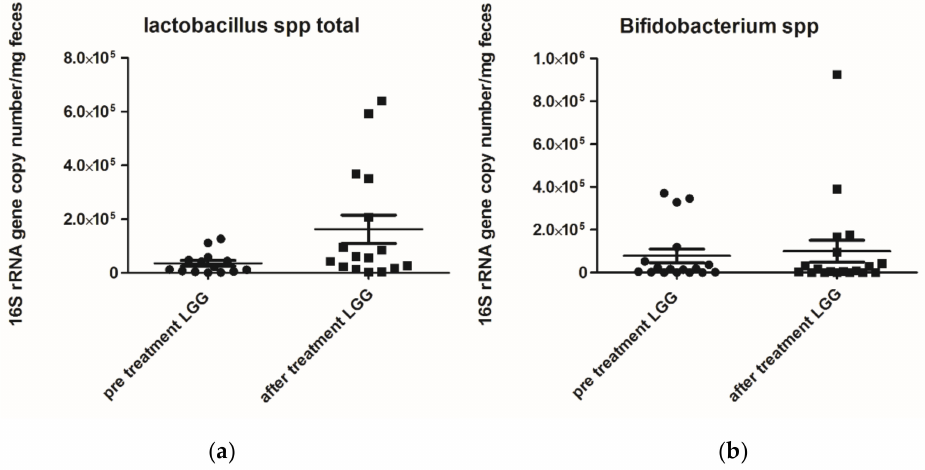
Figure 2. ( a ) Lactobacilluss spp. 16S rRNA gene copy number (mg / faeces) pre- and post-treatment with Lactobacillus rhamnosus ATCC 53103 (LGG) p value 0.0483; ( b ) Bifidumbacterium spp. (mg / faeces) pre- and post-treatment with Lactobacillus rhamnosus ATCC 53103 (LGG) p value 0.8245. Footnote: The data are represented as black dots. 16S rRNA gene copy numbers were assessed by real-time PCR and represented 16S rRNA gene copy number / mg feces. The statistical significance was calculated by the Mann–Whitney t